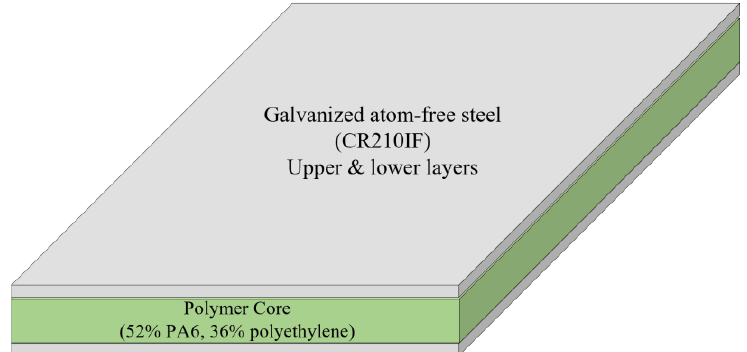
Figure 1. Three layers of LITECOR ® panel. Table 1. Mechanical properties of the LITECOR ® panel [8].